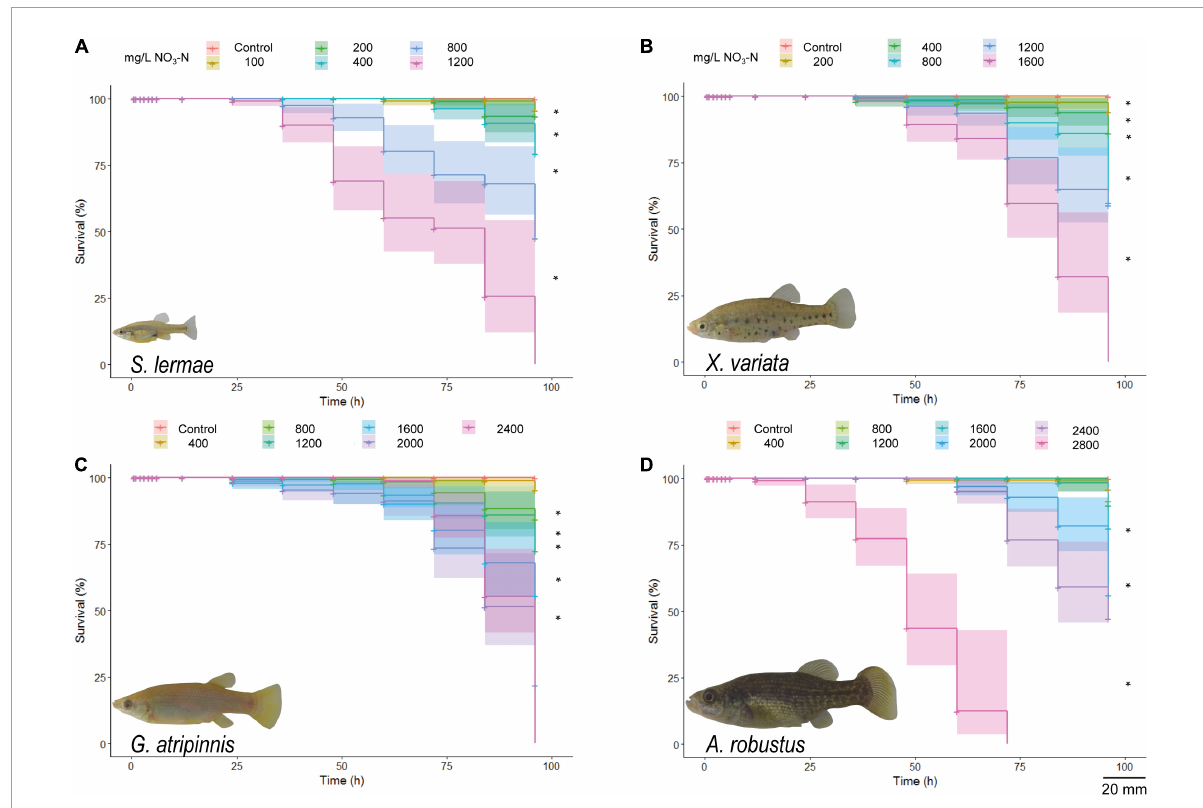
FIGURE1 Kaplan-Meier survival curves for S. lermae (A) , X. variata (B) , G. atripinnis (C) , and A. robustus (D) exposed to NaNO 3 -N. Log rank test indicated significant differences compared to the control groups ( n = 30, * p < 0.001). Shading: 95% confidence intervals. Representative photograps of each species are shown (scale bar =